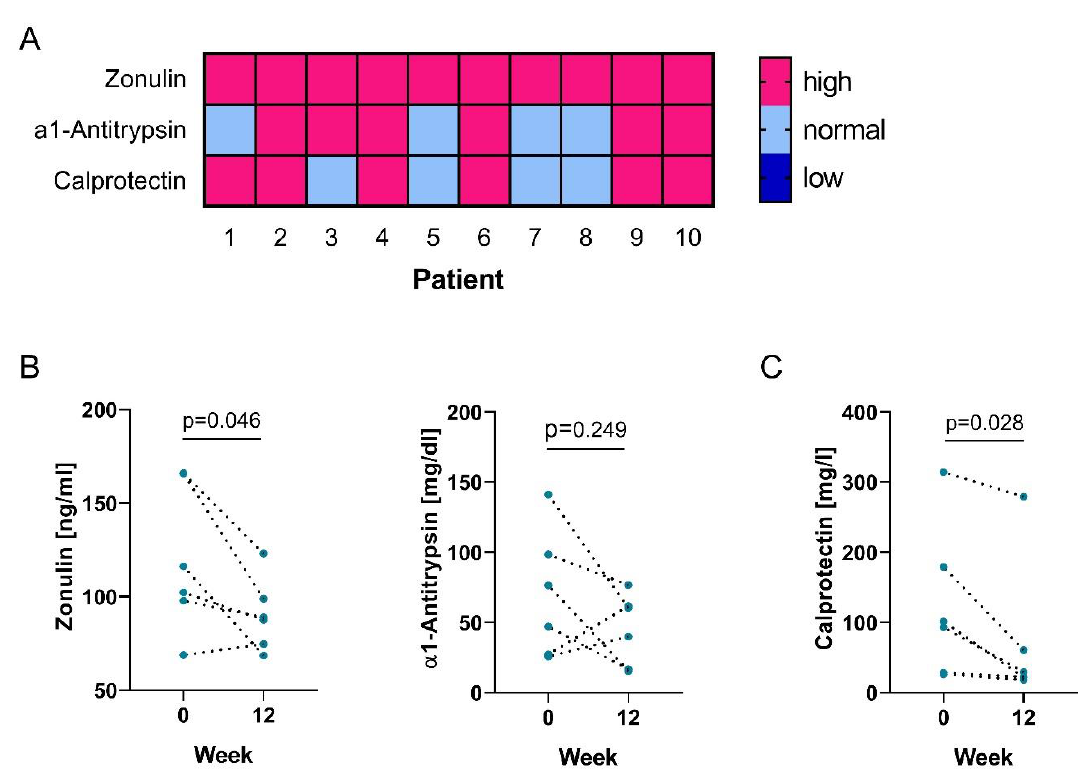
Figure 2. Intestinal permeability is increased in PsA patients and ameliorates with probiotics intake. ( A ) Heatmap showing too low (dark blue), normal (light blue) and too high (pink) levels of markers of gut permeability (zonulin and α 1-antitrypsin) and intestinal inflammation (calprotectin) in PsA patients; Graphs show ( B ) fecal concentrations of zonulin (left) and α 1-antitrypsin (right); ( C ) fecal concentrations of calprotectin at baseline (0) and week 12 of treatment with probiotics.